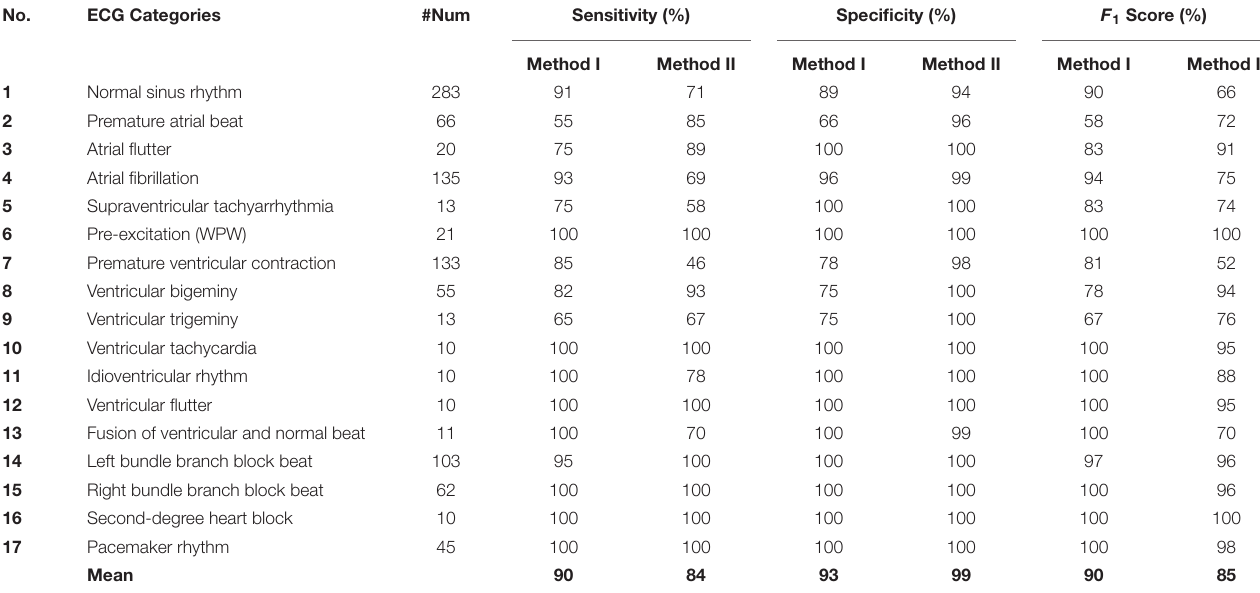
TABLE 1 | Classification performance of Method I and Method II on Database